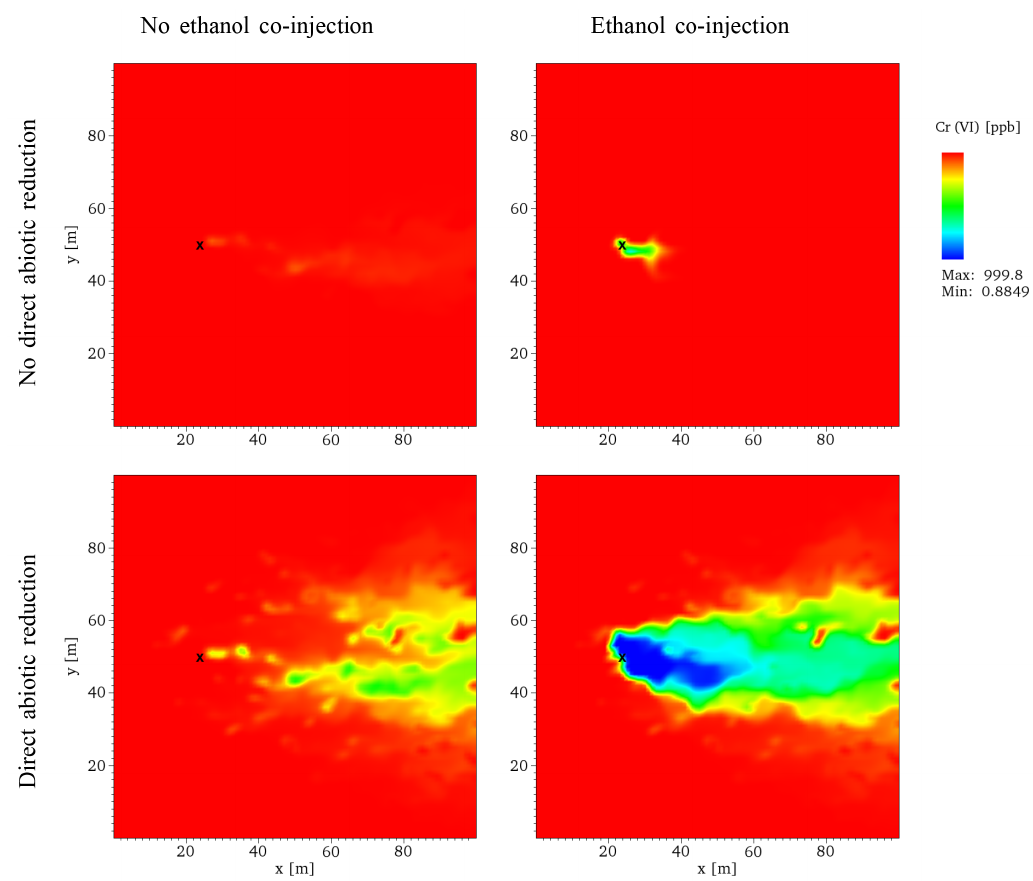
Figure 1. Maps of Cr(VI) concentrations (ppb) in the aquifer 470 days after injection ceased in each of the four scenarios discussed in Sect. 3.1. Injection well location is denoted by a black